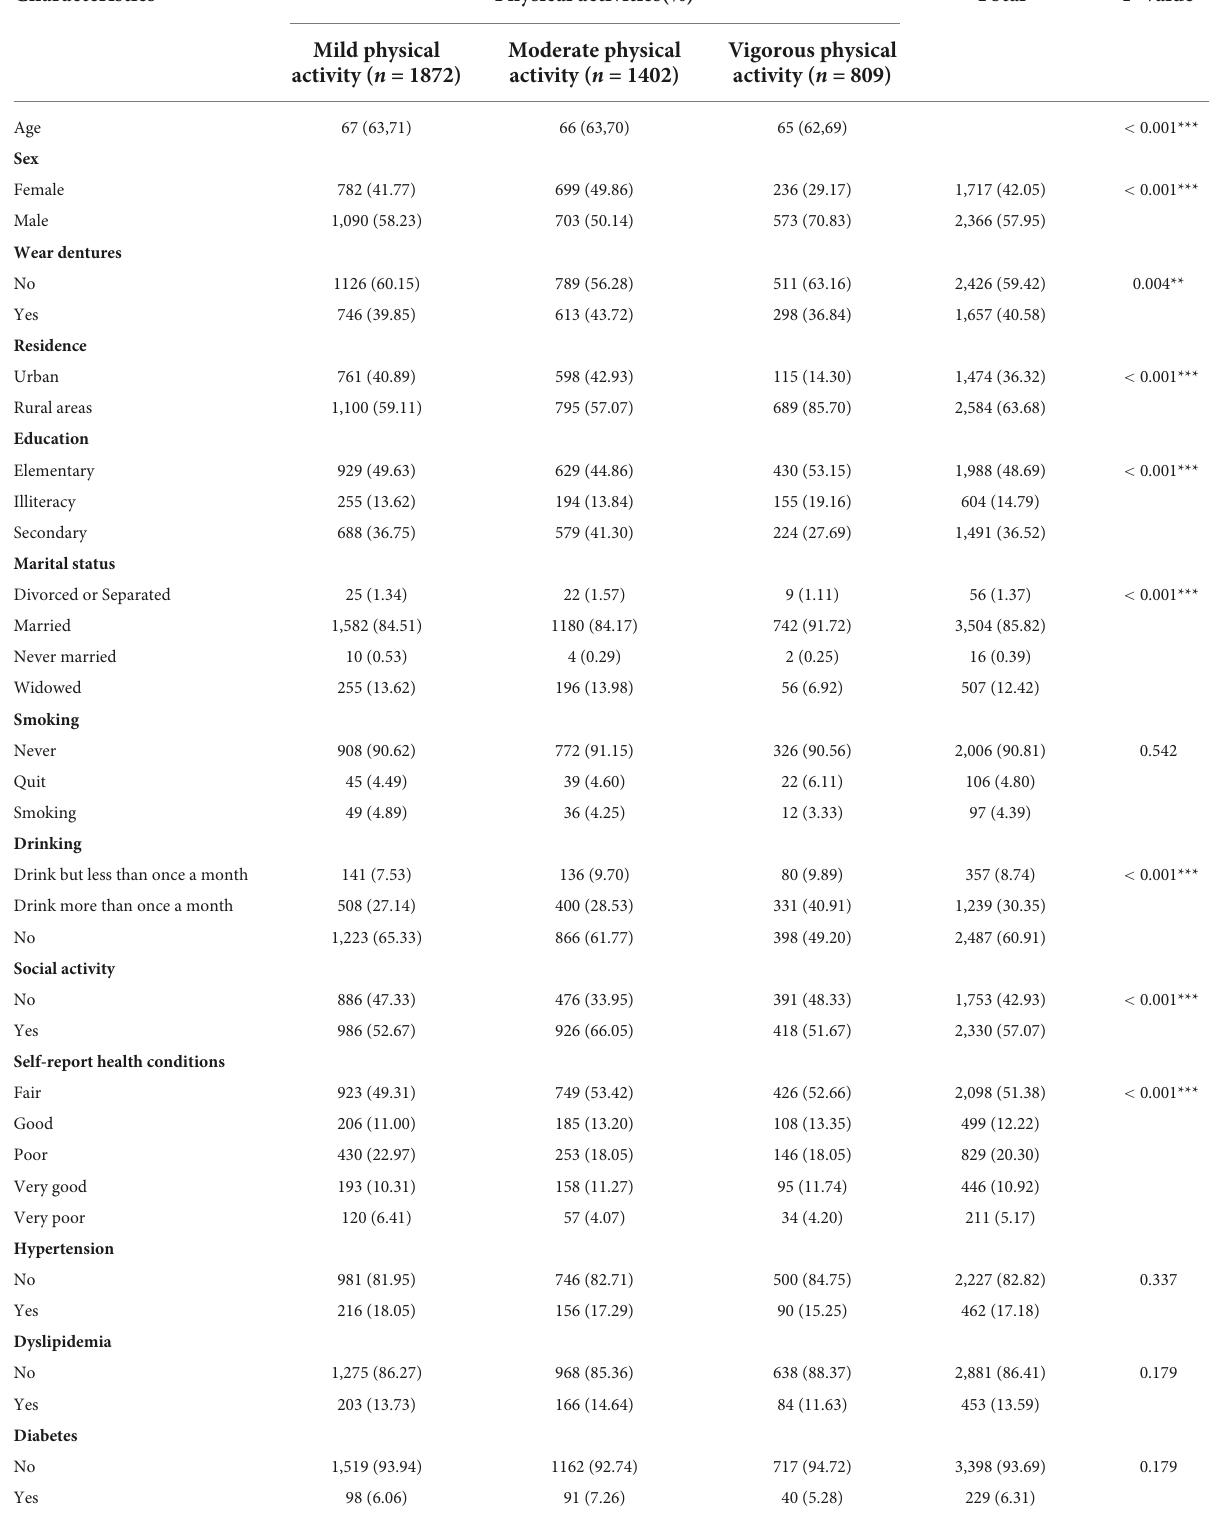
TABLE 2 Baseline characteristics of study participants without cognitive impairment according to physical activity status.